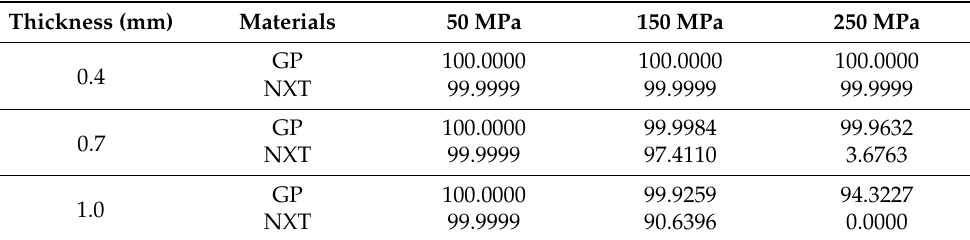
Table 5. Reliability of Graphy and NextDent materials at different thicknesses under compressive forces of 50, 150, and 250 MPa.